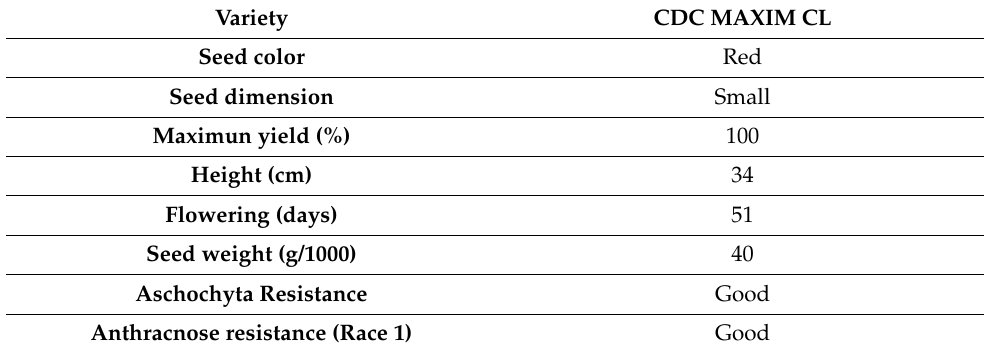
Table 1. Characteristics of lentil ( Lens culinaris L.) variety CDC MAXIM CL used in this study [24].